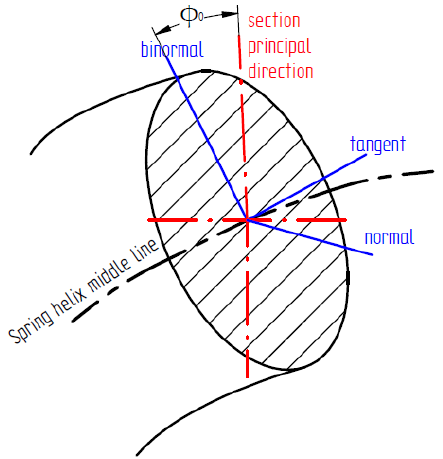
Figure 4. Intrinsic trihedral and principal directions of inertia of the section.